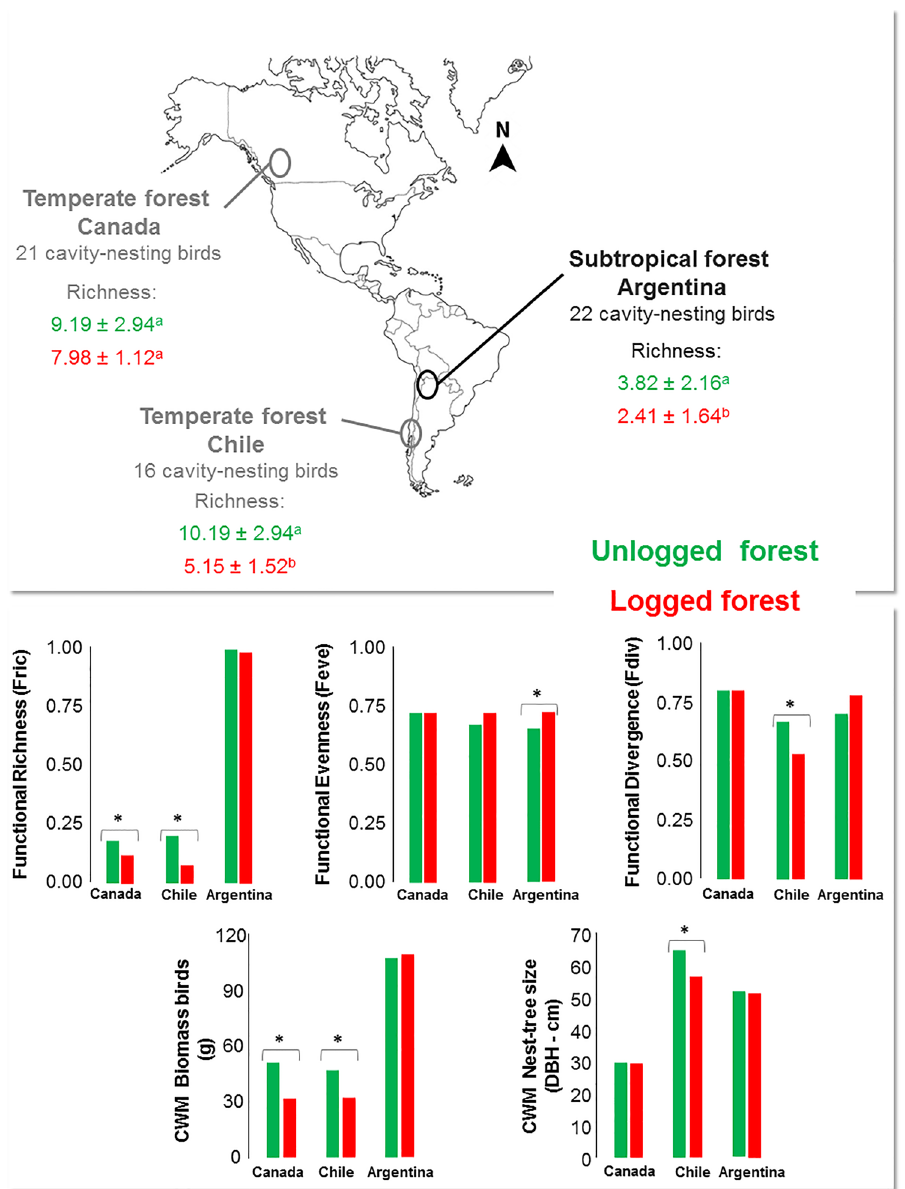
Figure 2. Functional richness and diversity in both temperate forests in Canada and Chile and subtropical forests in Argentina. The number of bird species and species richness for each site is also noted above: distinct letters indicate differences in the mean values between treatments. Functional diversity indices measured in all sites (below) and significant differences in mean values between treatments (*) are also depicted. This figure was produced using INFOSTAT software (//www. infos tat. com.